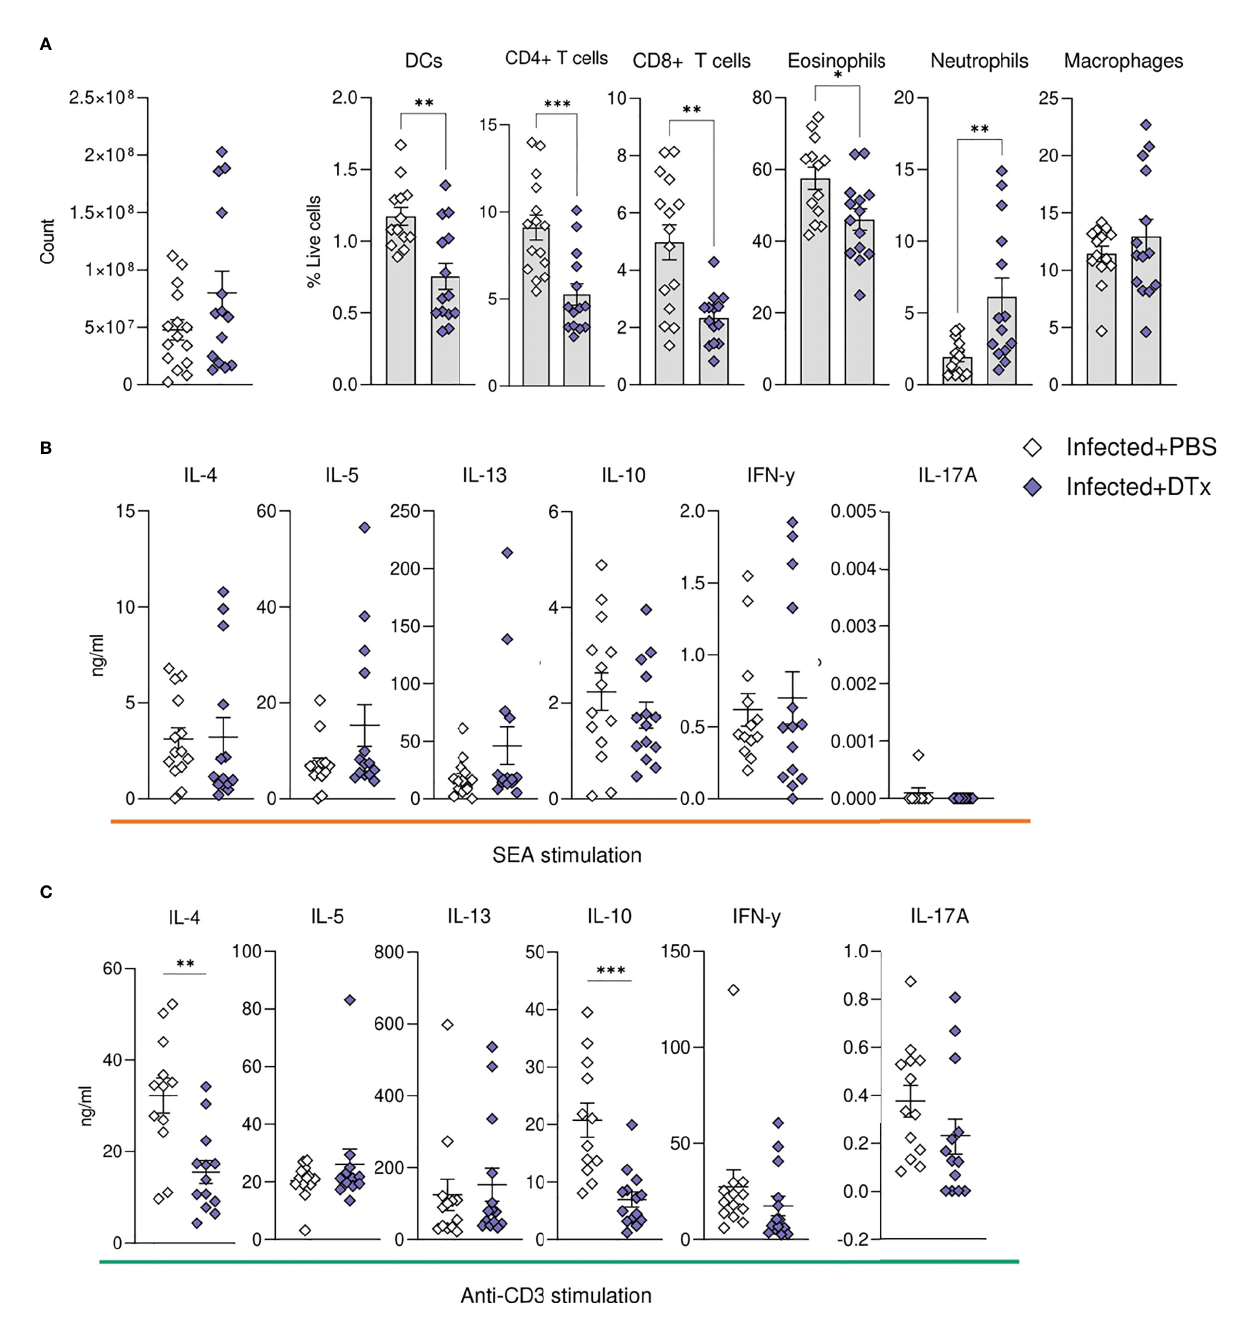
FIGURE 7 | CD11c depletion compromises hepatic cellular dynamics during S. mansoni infection. CD11c.DOG mice were infected with 40 S. mansoni cercariae, with CD11c+ cells depleted on d42-51 via Dtx administration, and mice culled on d52. The total number of liver cells (A) and the frequency of various immune cells in the liver of Dtx of PBS treated infected mice. Liver cells were cultured for 72 h with (B) 0.25 µg of SEA or (C) 0.5 m g of anti-CD3. Supernatants were collected and cytokine production (medium alone values subtracted) was assessed by ELISA. Data are pooled from 3 separate experiments (n=12-18 animals per time point). Signi fi cance calculated by unpaired T-test. Data presented as mean +/- SEM. *p < 0.05, **p < 0.01, ***p <